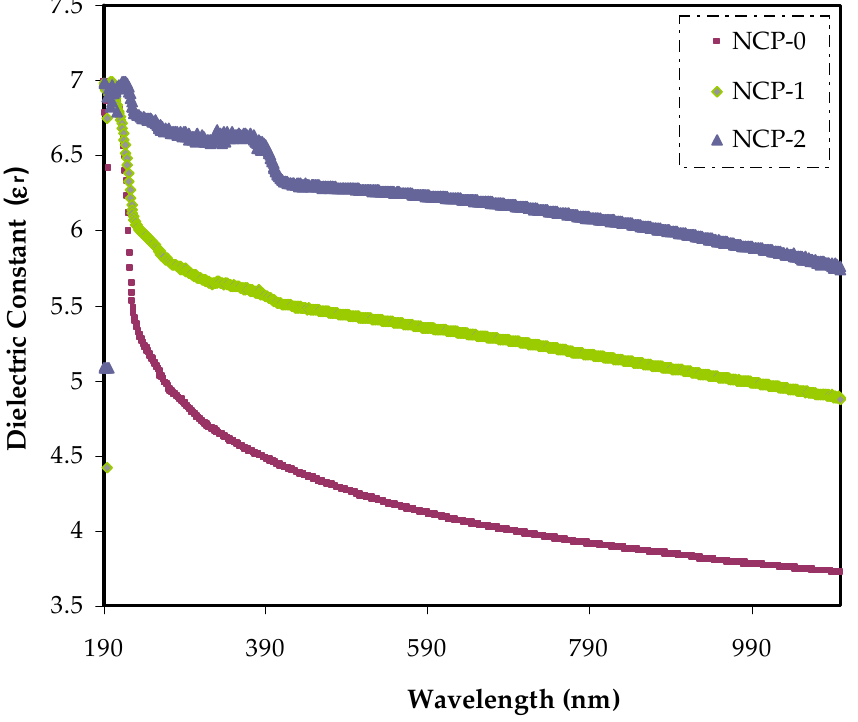
Figure 12. Dielectric constant vs. wavelength for NCP-0 and composite films. Using ε i extrapolation at the plateau region to the Y axis was useful in extracting the ε i of the PEO and 4 and 8 wt.% of PEO/CaTiO 3 nanocomposite samples. Incorporating the CaTiO 3 nanoparticles into PEO increased the ε i value as a consequence of creating new states. In other words, there was an existence between the ε i and density of states through forbidden gaps in the materials [52,53].